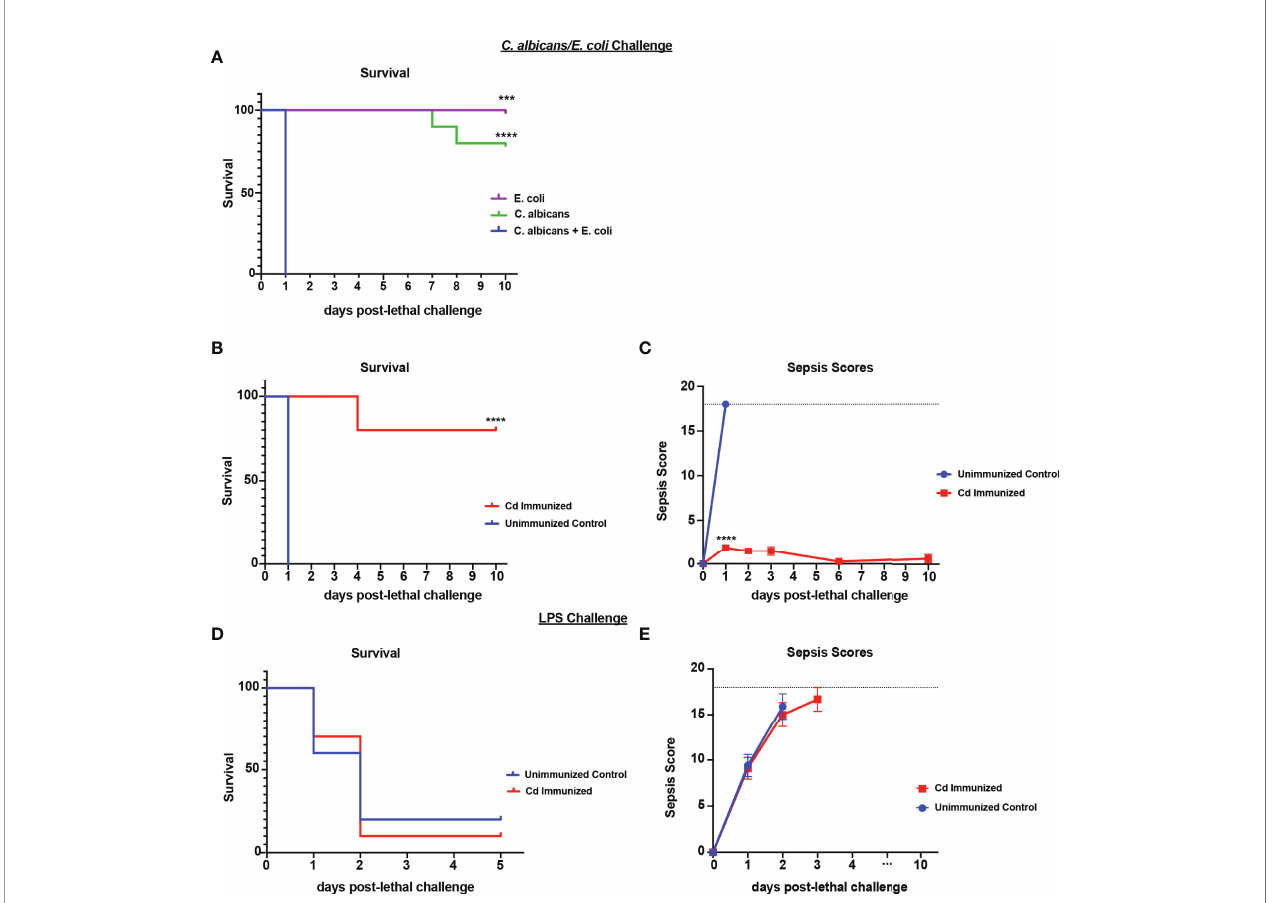
FIGURE 1 | Immunization with Candida dubliniensis induces protection against polymicrobial C. albicans / E. coli IAI but not LPS-induced sepsis. Initial studies con fi rmed that polymicrobial challenge of C. albicans (1.75x10 7 CFUs) and E. coli (4.5x10 6 CFUs) was lethal whereas monomicrobial challenge was not lethal (n=10 mice/group) (representative results of six repeats shown in A ). For protection studies, mice (n=10/group) were given 1.75x10 7 CFUs of live C. dubliniensis (strain Wü284), i.p. as an immunization followed by challenge with lethal C. albicans (1.75x10 7 CFUs) and E. coli (4.5x10 6 CFUs) (B, C) or lethal LPS (10 mg/kg) (D, E) , i.p. and monitored for survival and morbidity/sepsis scoring following lethal challenge for 10 days. Animals receiving no primary challenge served as the negative (lethal) control. Mice were monitored and scored for 10days post-lethal challenge. Graphs are representative of at least 3 separate experiments. *, P<0.05; **, P<0.01; ***, P<0.001; ****, P<0.0001 [for values signi fi cantly different from those of the control, by log rank Mantel-Cox test (survival) and ANOVA followed by post hoc Student ’ s t-test (sepsis